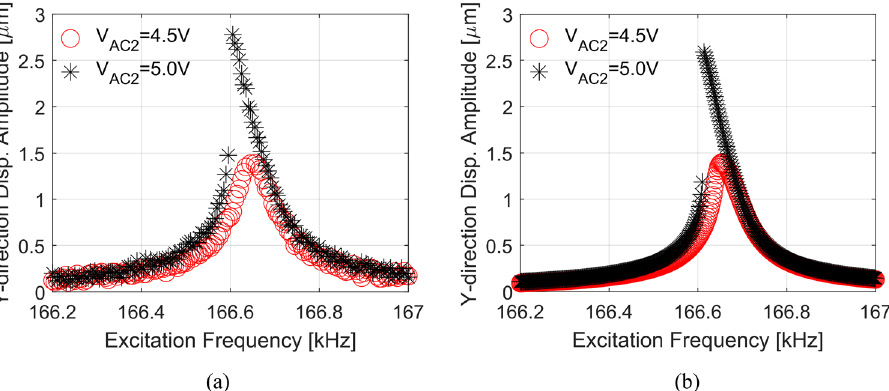
Figure 5. Frequency response curves near the 2nd resonance frequency with no DC load when actuating the structure with Electrode 2 (E2). ( a ) Experimental data. ( b ) Numerical simulations. Both figures indicate linear response and softening nonlinear behavior at V AC2 = 4.5 V and V AC2 = 5.0 V, respectively.